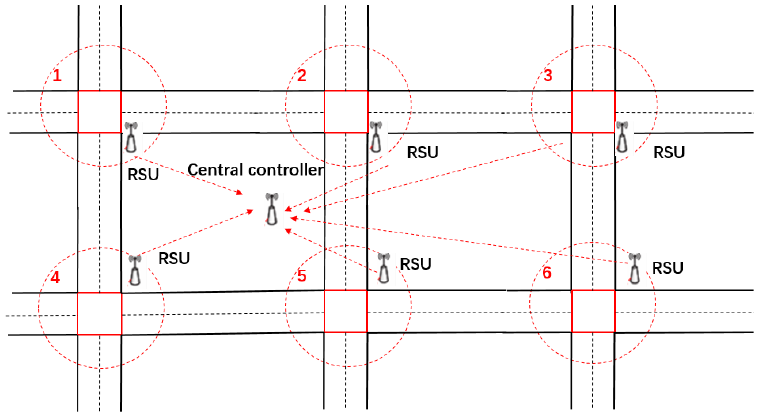
Figure 7. A typical road network with six intersections. Numbers 1–6 stand for the intersection number.